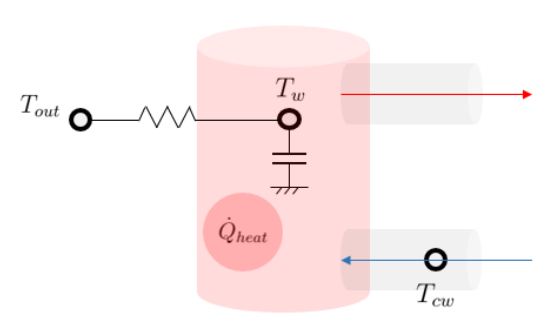
Figure 2. Domestic hot water state space model